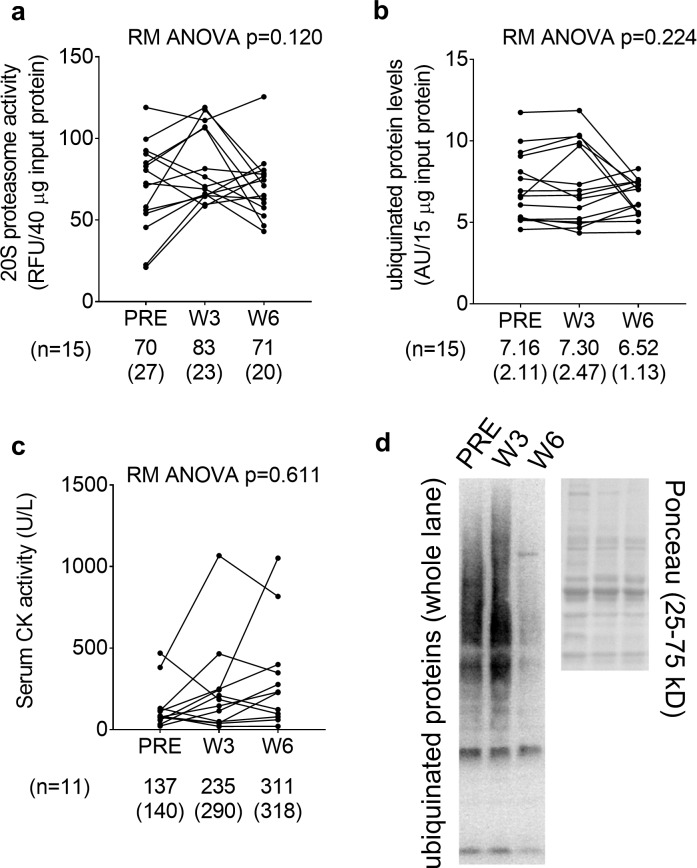
PRE, W3, and W6 VL biopsy proteolysis and muscle damage markers.All line graph data show individual responses with mean ± standard deviation (SD) values below each time point. 20S proteasome activity (panel a), ubiquinated protein levels (panel b), and serum CK activity (panel c) did not significantly change over time. Panel d illustrates a representative Western blot image of ubiquinated protein levels from one subject.